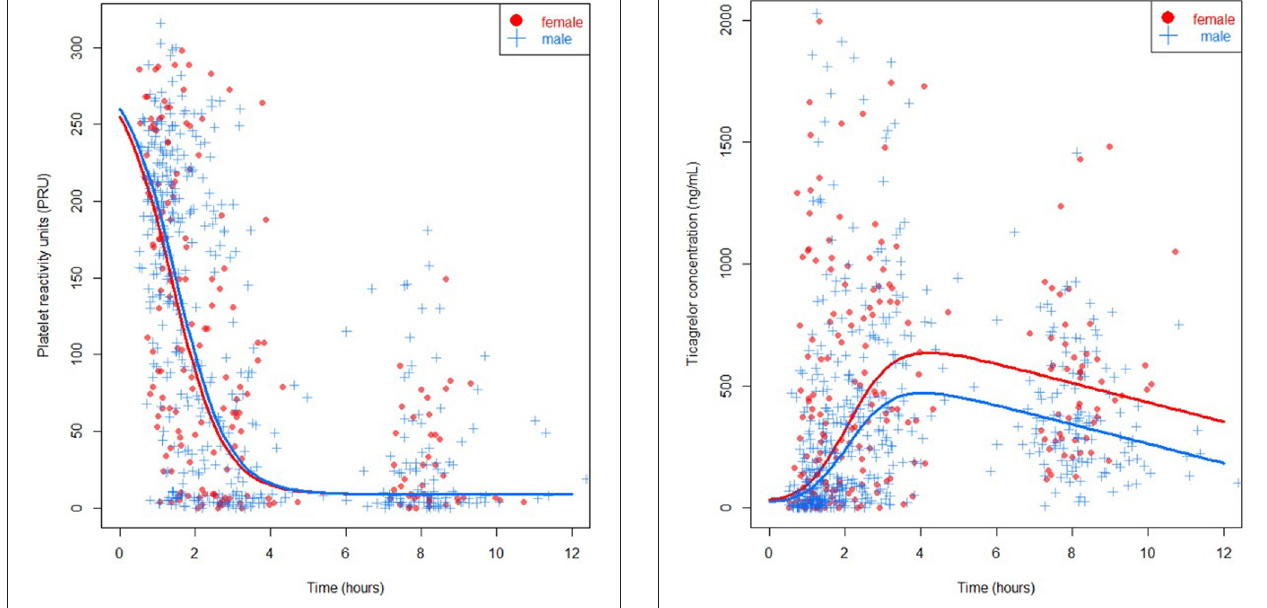
FIGURE 1 | PRU specified for sex ( P = 0.93), females in red, males in blue. FIGURE 2 | Ticagrelor concentration specified for sex ( P = 0.04), females in red, males in